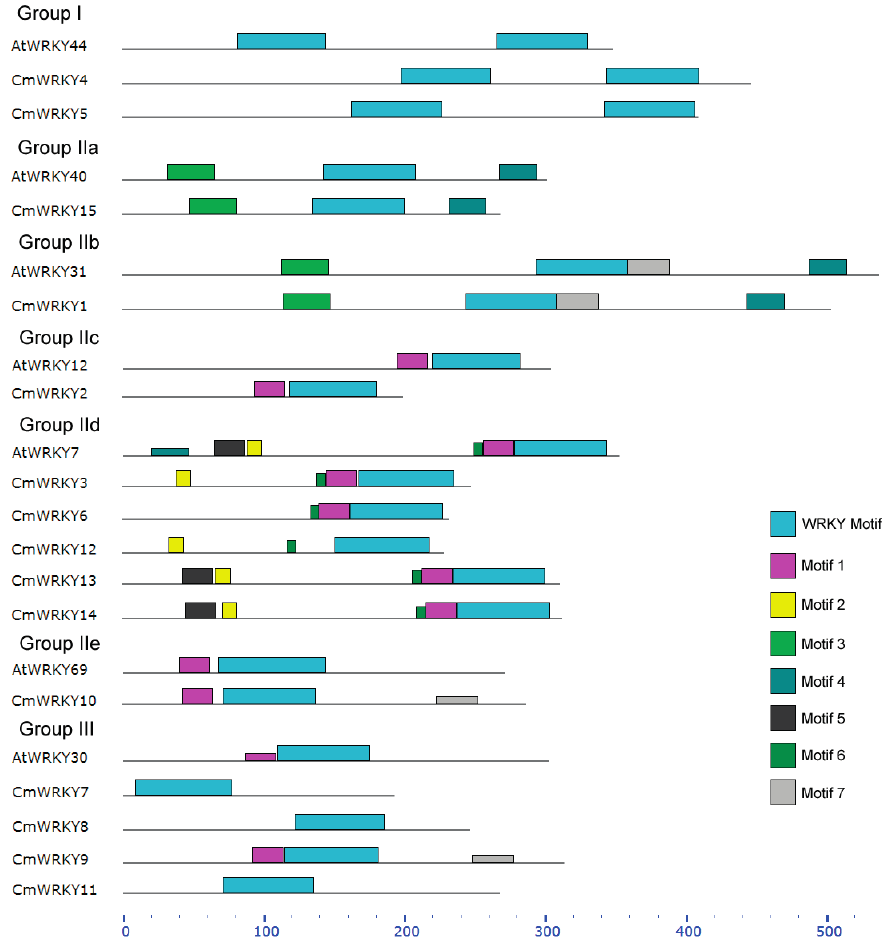
Figure 2. The amino acid motifs present in the CmWRKY and AtWRKY proteins, as determined by Meme 4.8.1 software [19]. The cyan boxes represent WRKY motif, and other colored boxes each represent a specific motif with uncharacterized